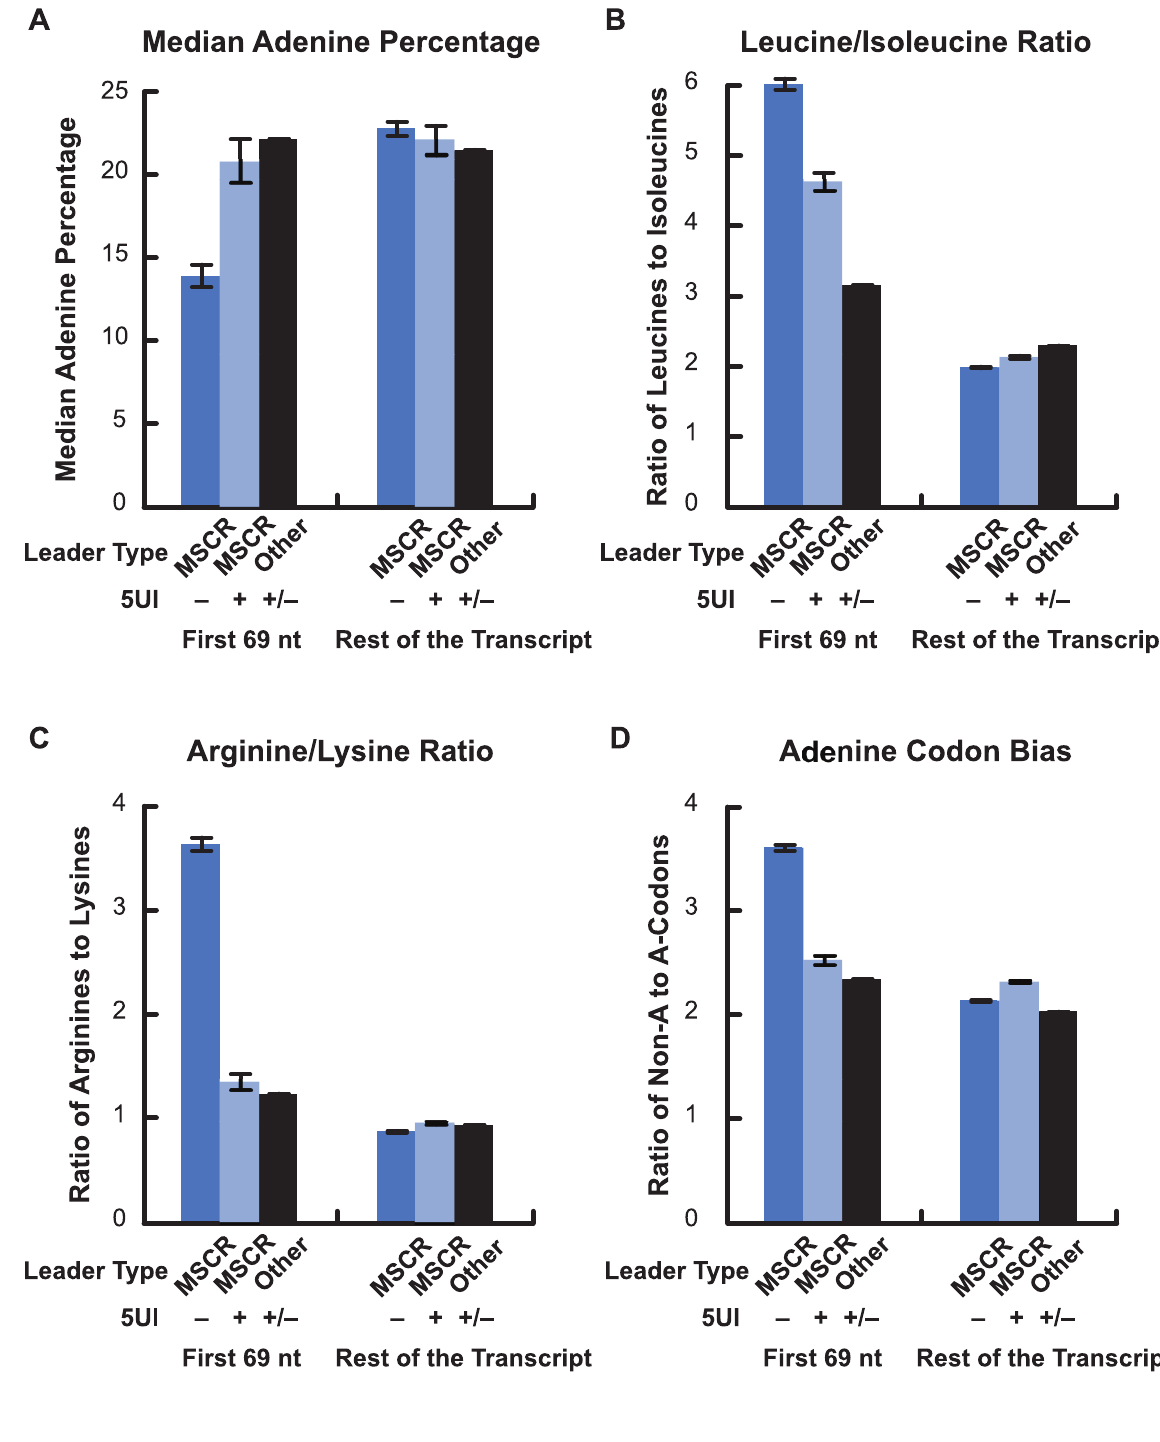
Figure 4. Adenine depletion in MSCRs derived from 5UI 2 genes. As in Figure 2A, all bars represent the average from the first 69 nucleotides of all MSCRs-containing open reading frames from the human genome which either lacked (‘‘–‘‘) or had (‘‘ + ’’) 5UIs. As controls these sequences were compared to the rest of the open reading frame, or analogous regions from open reading frames that lacked SSCRs (‘‘other’’). Error bars correspond to the standard error of the median or mean, as appropriate. Panels A-D are as described for Figure 2. See Figure S3 for examples of adenine codon bias for specific amino acids (leucine and serine).